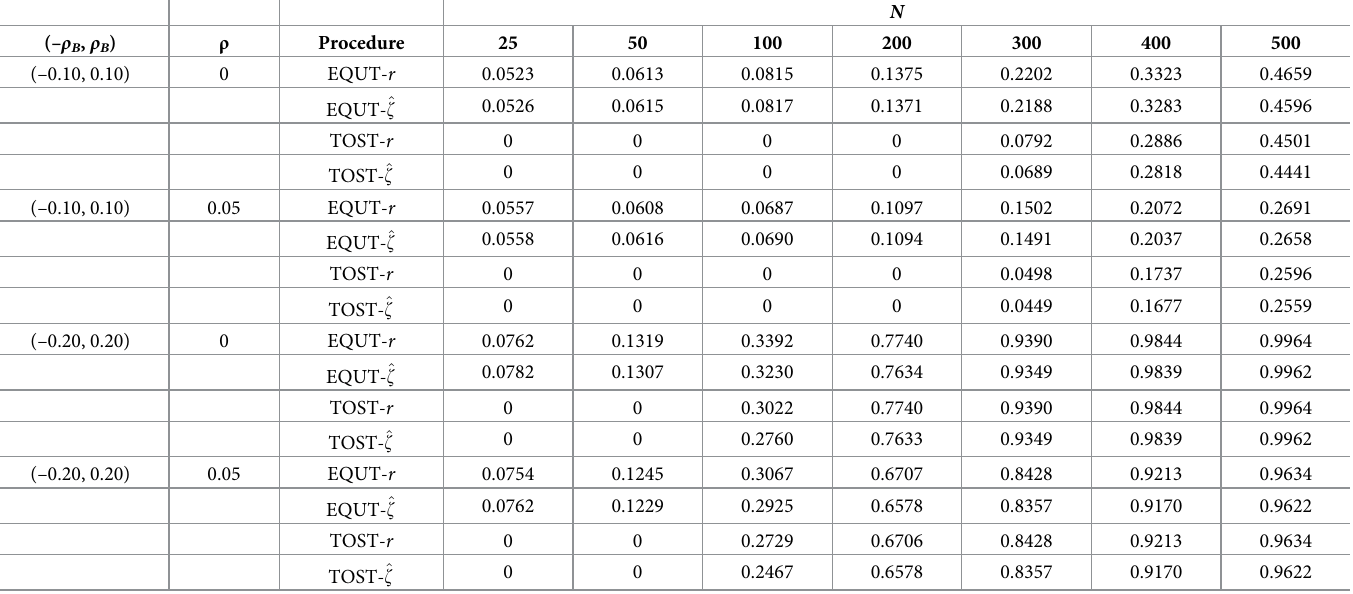
Table 4. The simulated powers of the lack of association tests for α =